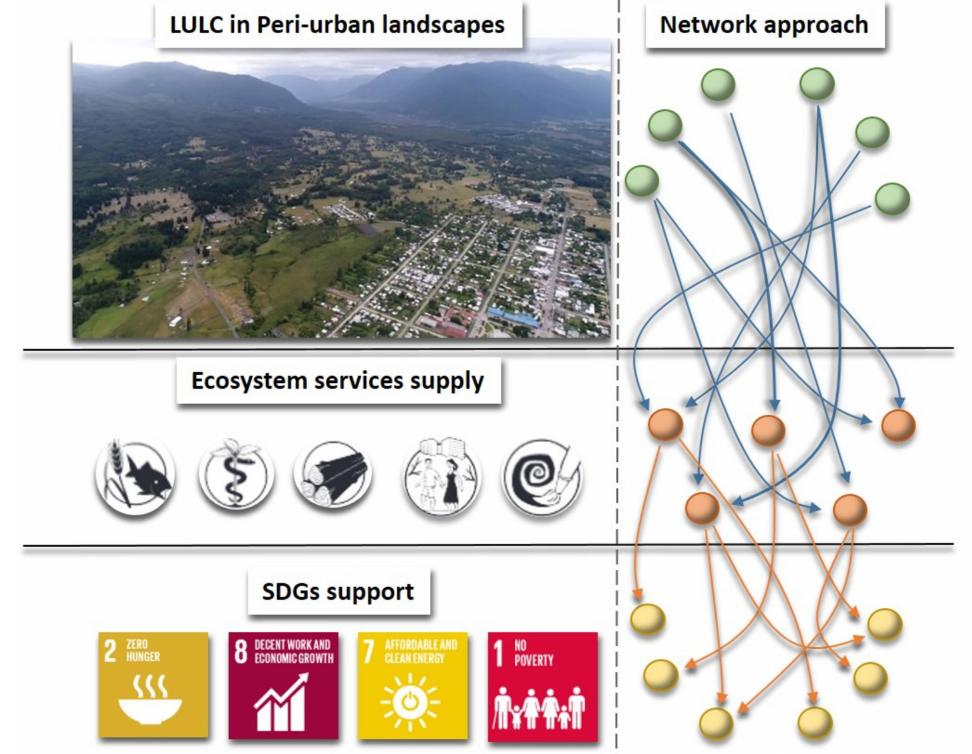
Figure 2. Schematic representation of the network interactions among LULC, ES, and SDGs. The illustrations for ES belong to the TEEB project (https://teebweb.org/ (accessed on 11 April